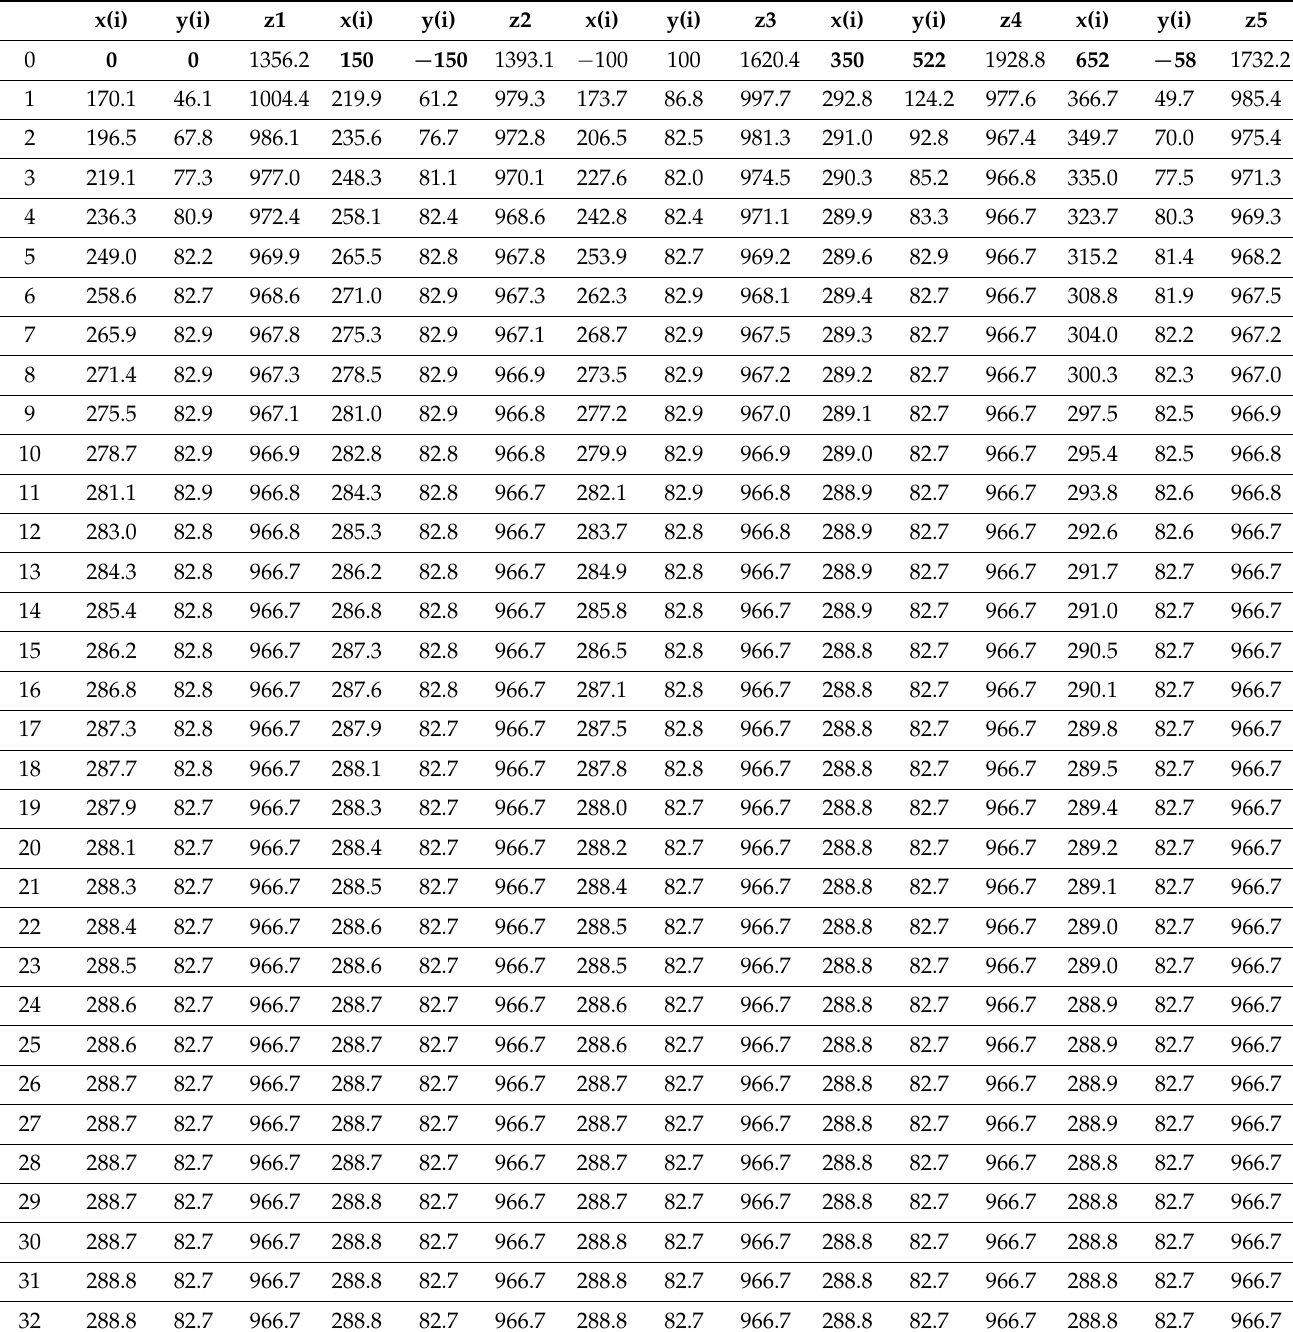
Table 3. Iteration procedure and value of the objective functions for calculating the optimal position of the distribution centre for different